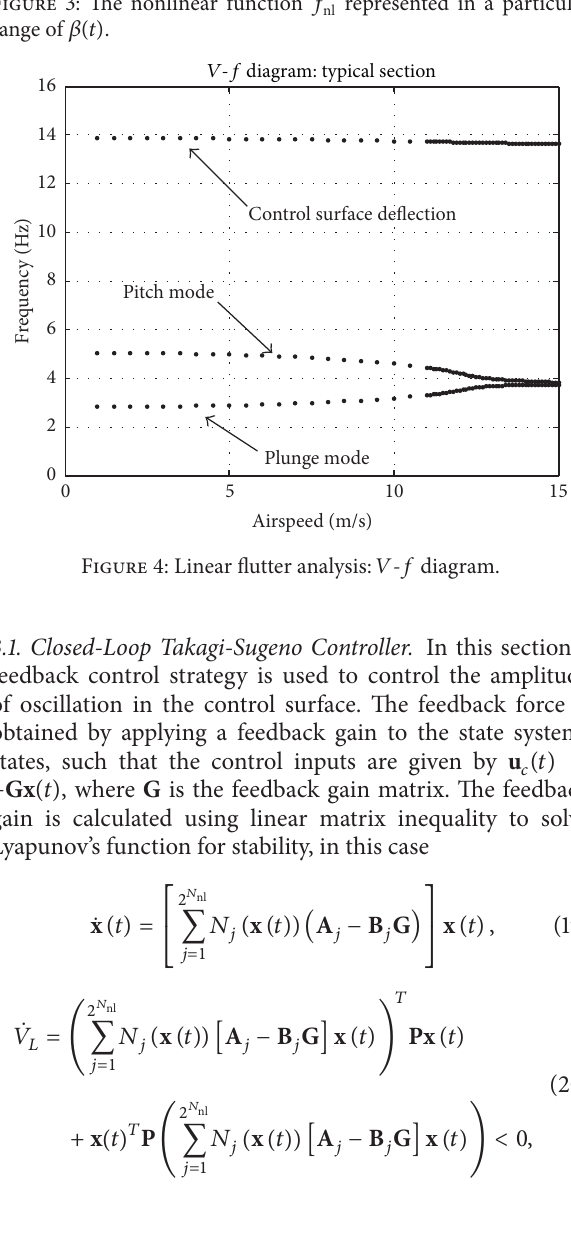
represented in a particular nl